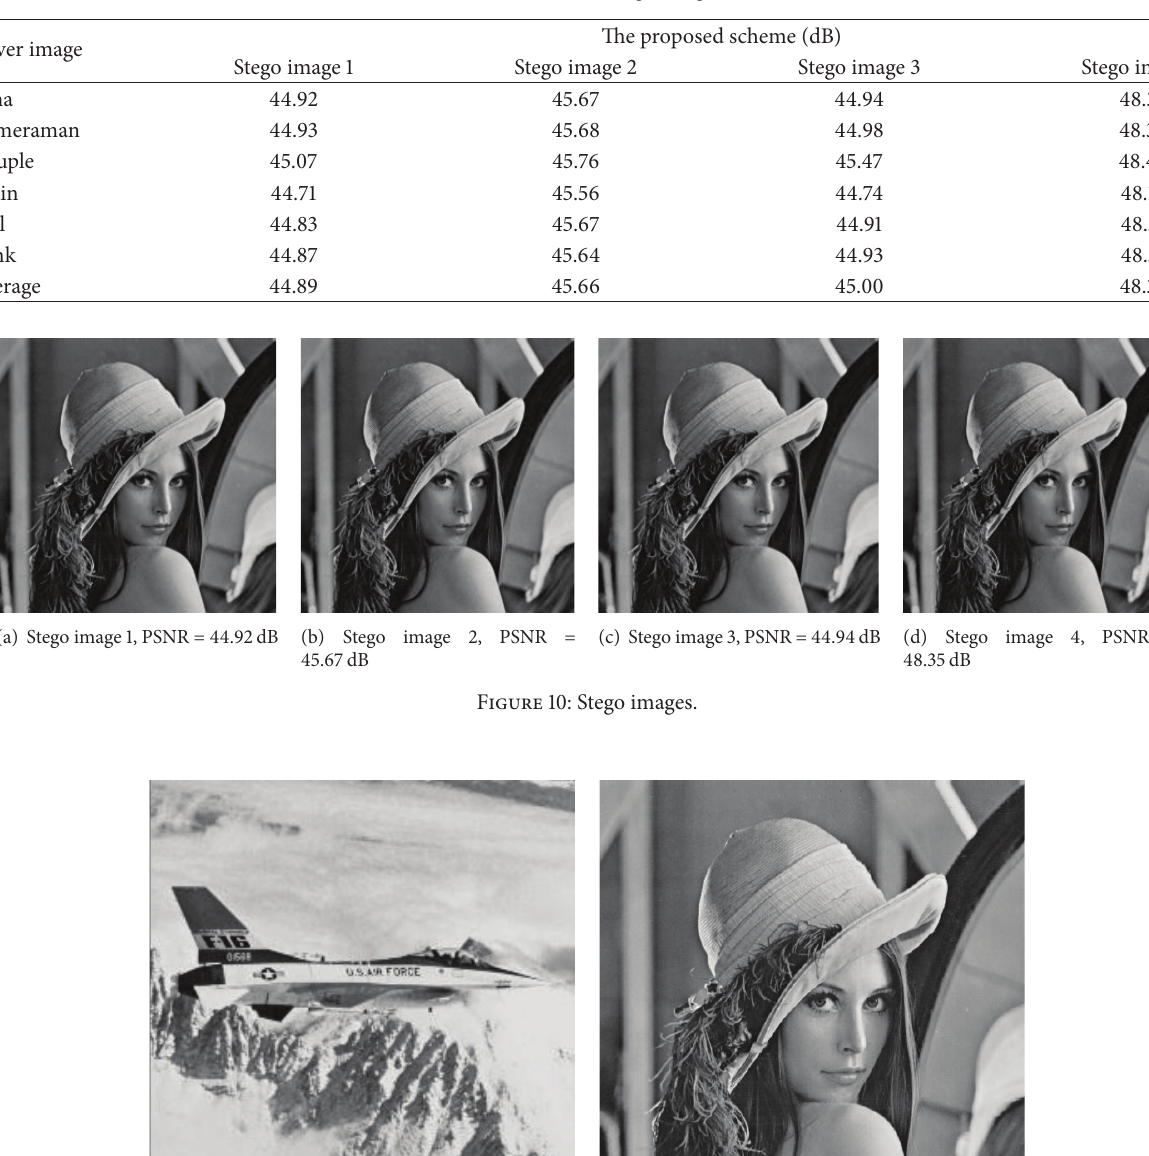
Table 7: PSNR of stego images.